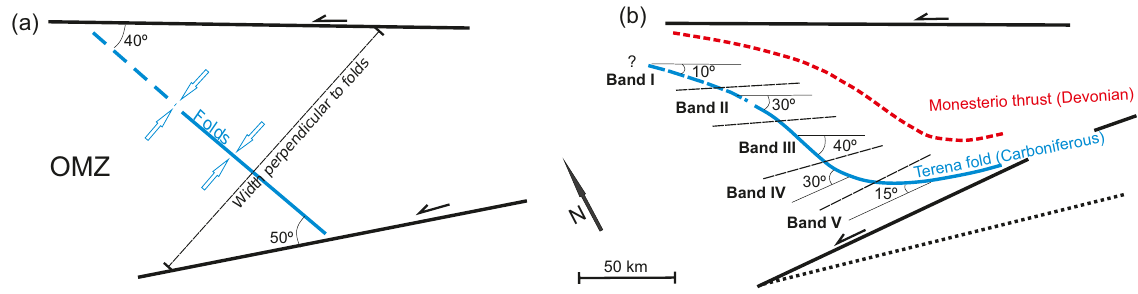
Figure 5. Stages of Carboniferous shortening inside the OMZ. (a) NE–SW compression gave way to a set of upright folds. (b) Folds rotation by heterogeneous left-lateral shearing. The five different bands considered to analyze the deformation are